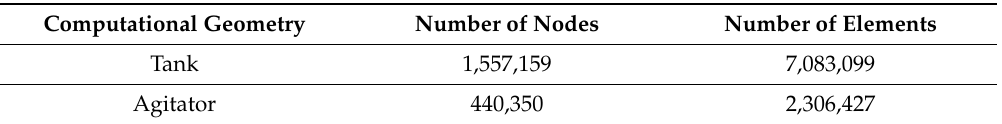
Table 1. Mesh information.